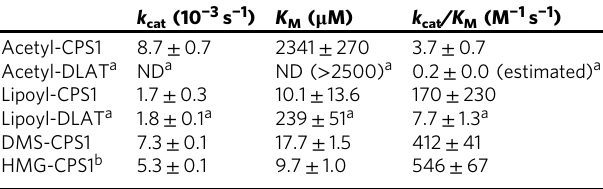
Table 1 Kinetic parameters for Sirt4 and acyl